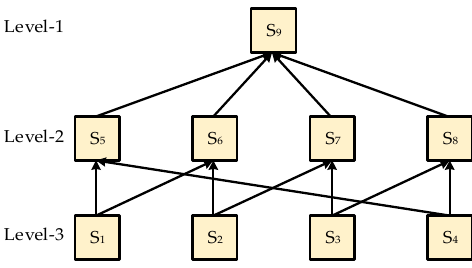
Figure 5. Layered fusion structure of sharing sensors.